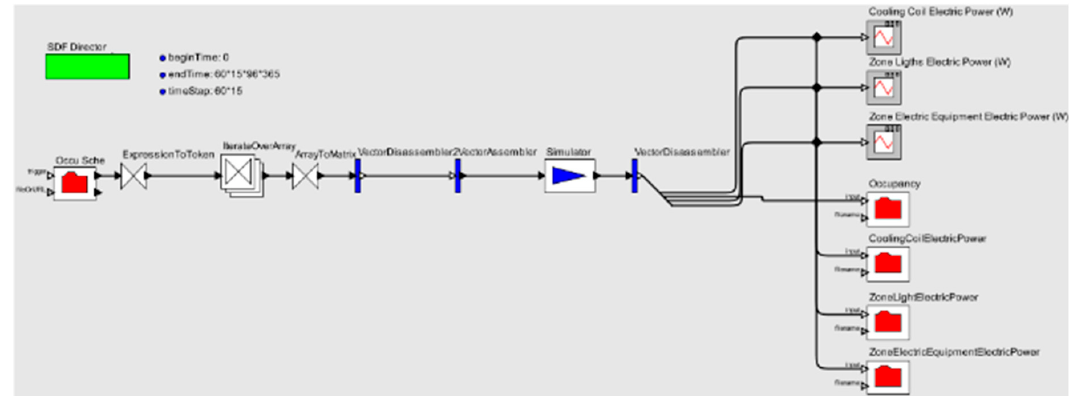
Figure 10. Developed actual occupancy based energy simulation environment on BCVTB.